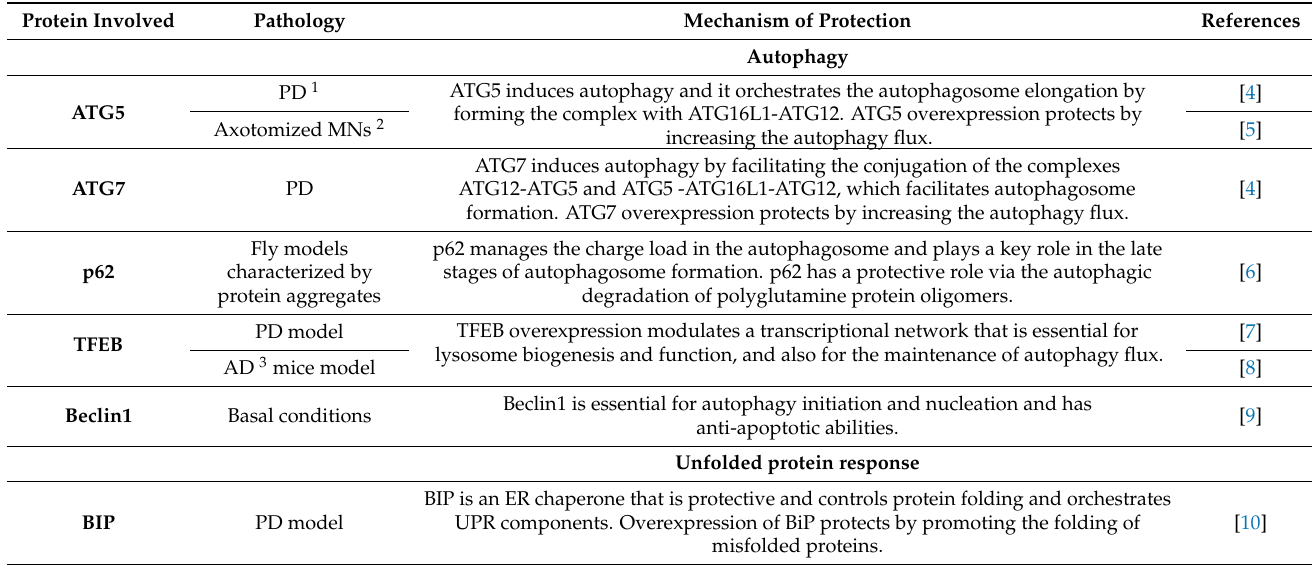
Table 1. Summary of the proteins involved for each endogenous mechanism of neuroprotection, including the molecular mechanism by which their effects are